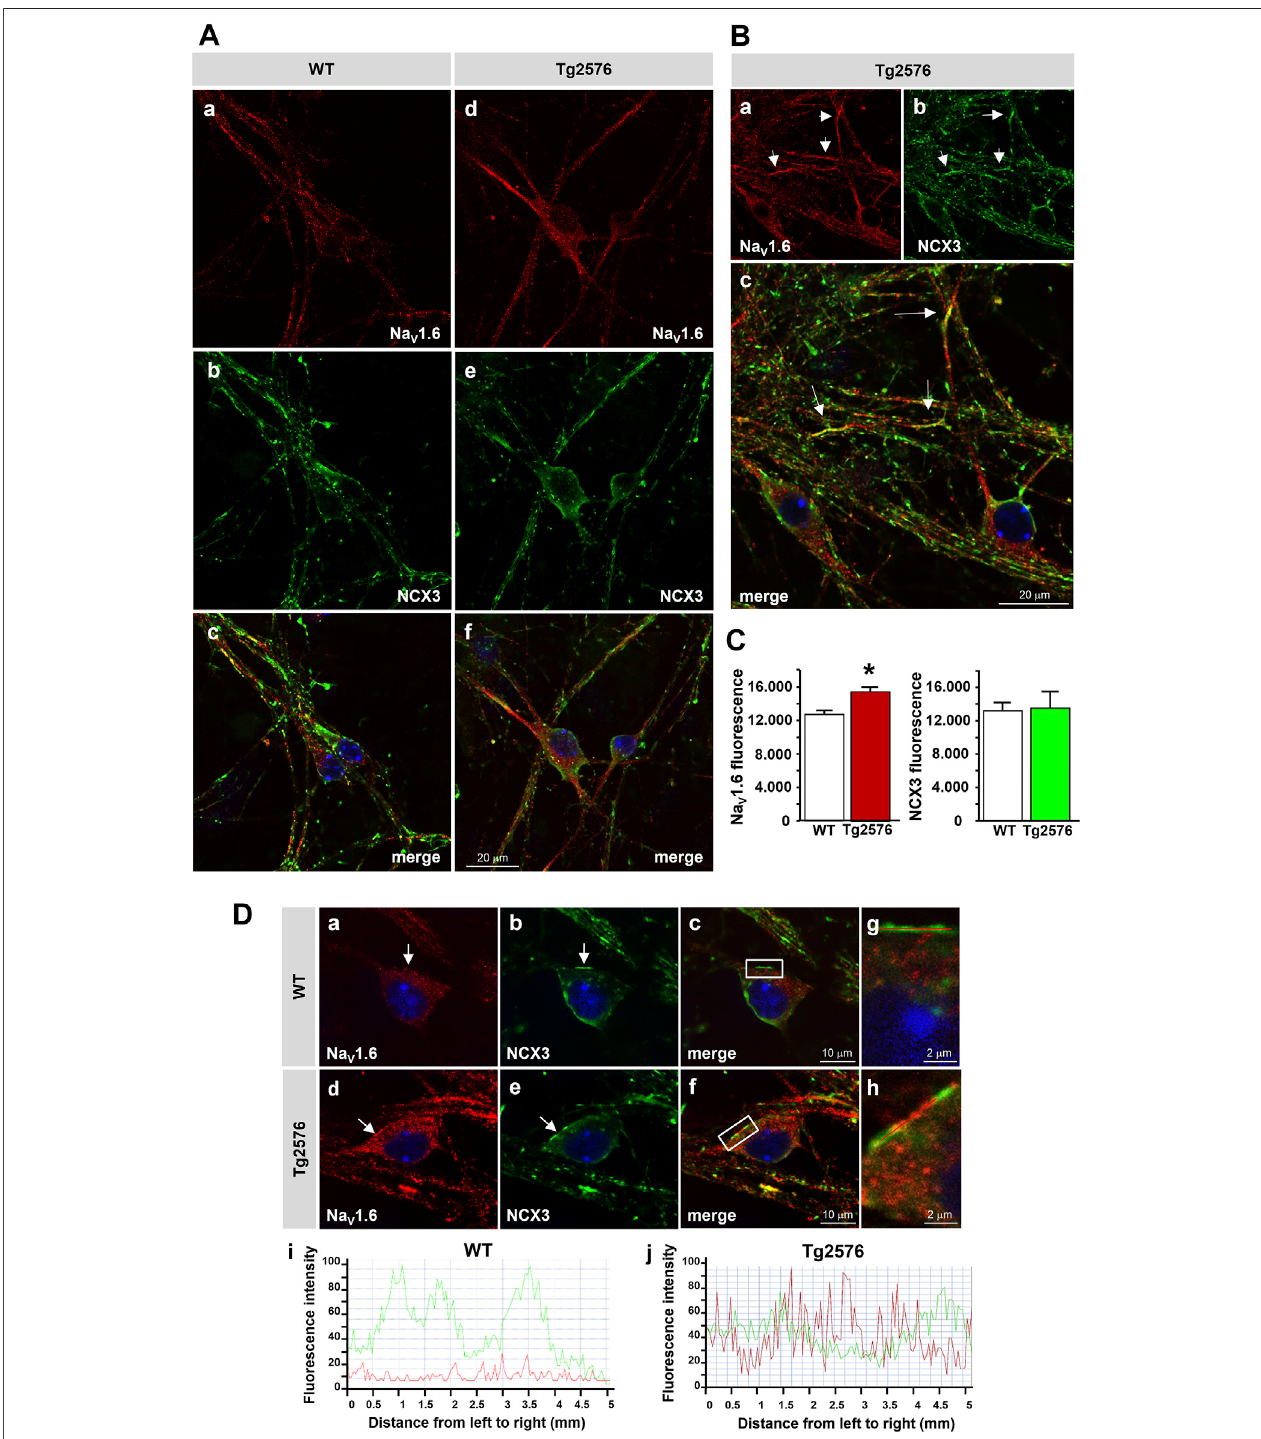
FIGURE 4 | Distribution of Na V 1.6 channels and NCX3 in Tg2576 primary hippocampal neurons. (A) Confocal microscopic images displaying the distribution of Na V 1.6 (red) and NCX3 (green) immunoreactivities in hippocampal neurons isolated from WT and Tg2576 mouse embryos and cultured for 12 DIV (scale bars: in a – f: 20 µm). (B) Confocalmicroscopic imagesdisplaying thedistribution ofNa V 1.6(red) andNCX3(green)immunoreactivitiesinTg2576primaryhippocampalneuronsat12 DIV. Arrows in a-c point to the intense co-localization of Na V 1.6 and NCX3 immunostaining along neurites (scale bars: 20 µm). (C) Densitometric analysis of